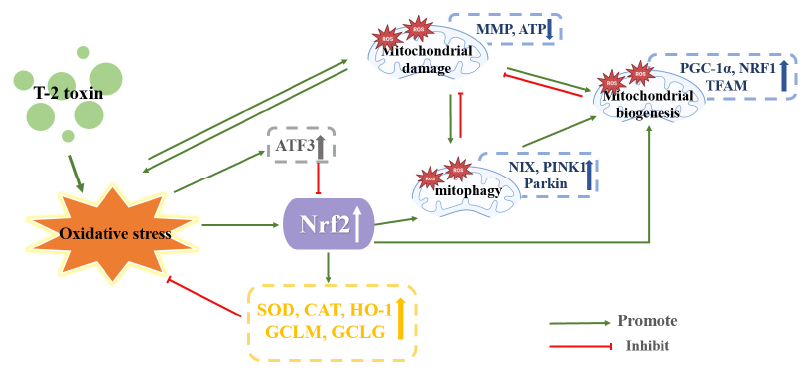
Figure 7. Mechanism of endocrine toxicity induced by T-2 toxin. Blue, yellow, gray, and white arrows, arrows up indicate increased expression and arrows down indicate decreased expression.